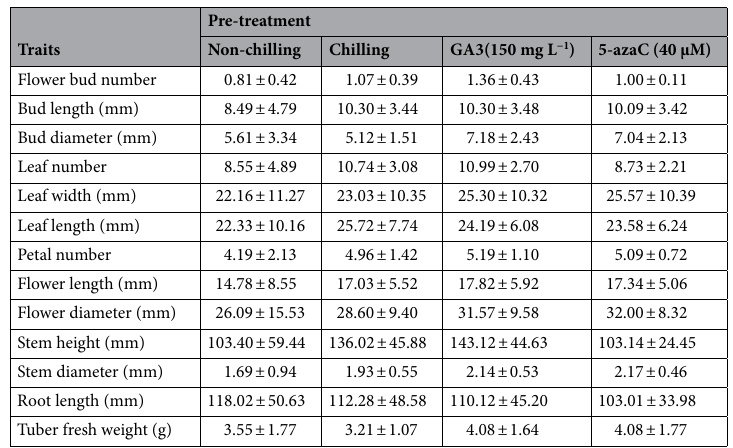
Table 3. Mean values ± SD for morphological traits under different pre-treatment conditions in 18 studied accessions of